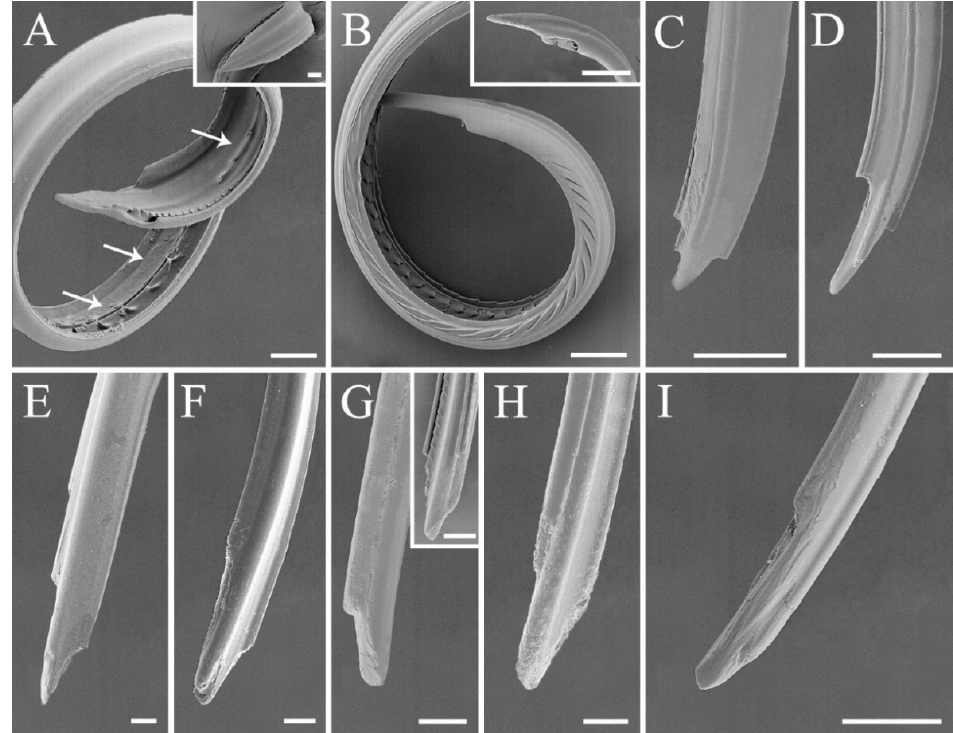
Figure 8. Maxillary stylets of the six pentatomid species. ( A , B ) Eocanthecona furcellata , with the external surface shown in the boxes and the arrows indicating the barbs; ( C , D ) Eurydema dominulus ; ( E , F ) Halyomorpha halys ; ( G , H ) Plautia crossota , with the internal surface shown in ( G ); ( I ) Scotinophara lurida . Scale bars: ( A – D ) 25 µ m, ( A , B ) 20 µ m, ( E , F ) 20 µ m, ( G – I ) 15 µ m, and ( G ) 25 µ m.